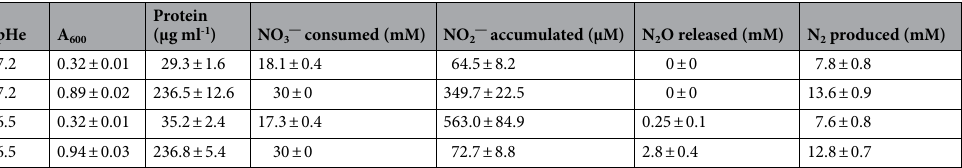
quantitative proteomic analysis by Liquid Chromatography-Mass Spectrometry/Mass Spectrometry (LC–MS/ MS). The principal component analysis (PCA) and the clustering of these biological replicates are shown as sup- plementary material (Figs. S1 & S2). Total proteins identified were 1157 at pH 6.5, 1734 at pH 7.0, 2014 at pH 7.2 and 1878 at pH 7.5 (Fig. 1B). Thus, the highest number of proteins was identified at pH 7.2, with 2014 proteins from ~ 5100 putative structural genes present in the P. denitrificans genome (~ 40% representation of the total predicted gene products). The protein profile obtained at pH 7.2 was used as the reference condition, and differential analyses were performed by comparison of the proteome at pH 7.2 with those at pH 6.5, 7.0 or 7.5. In these comparative pro- teomic analyses, the term ‘exclusive’ describes proteins with an absolute value of fold change higher than 100, whereas proteins shared at both analysed pHs, but nevertheless differentially represented with fold changes lower than 100, were considered ‘over-represented’ (positive fold change) or ‘down-represented’ (negative fold change) at the reference pH 7.2. The most drastic differences were observed when comparing the proteomes at pH 6.5 and 7.2, with a total of 922 proteins affected, of which 702 were exclusive to pH 7.2 and 10 were exclusive to pH 6.5. Another 158 proteins were over-represented at pH 7.2 (down-represented at pH 6.5) and 52 proteins were over-represented at pH 6.5 (down-represented at pH 7.2) (Table S1). A total of 584 proteins were differentially represented when comparing the proteomes at pH 7.0 and pH 7.2. In this case, 262 proteins were exclusive to pH 7.2, 85 were exclusive to pH 7.0 and 237 were shared at both pHs, with 148 proteins over-represented at pH 7.2 and 89 over-represented at pH 7.0 (Table S2). When comparing the proteomes at pH 7.5 and 7.2, 637 proteins were differentially represented, with 209 proteins exclusive to pH 7.2, 127 exclusive to pH 7.5 and 301 shared between both pHs, of which 172 were over-represented at pH 7.2 and 129 were over-represented at pH 7.5 (Table S3). The Gene Ontology (GO) categories 21 from the comparative analysis between pH 6.5 and 7.2 are shown (Fig. 2). Breaking down the proteome into GO groups gives insight into functional protein categories that are either enriched (over-represented) or suppressed (down-represented) under denitrifying and nitrate assimilating conditions. Proteins over-represented at pH 7.2 belonged to significantly changed GO groups ‘transmembrane transport’, ‘metabolic process’ ‘pentose phosphate shunt’, ‘pantothenate biosynthetic process’, ‘cobalamin biosyn- thetic process’, ‘leucine biosynthetic process’, ‘glutamine biosynthetic process’, ‘porphyrin-containing compounds biosynthetic process’, ‘biotin biosynthetic process’, ‘glyoxylate cycle’ and ‘nitrate metabolic process’, among others (Fig. 2A). Down-represented proteins at pH 7.2 belong to the GO groups ‘cell cycle’, ‘cell division’, ‘cell morpho- genesis’, ‘regulation of cell shape’, ‘cell wall organization’ and ‘hydrogen sulphide biosynthetic process’ (Fig. 2B). Effect of pH on peptide representation of proteins involved in denitrification and nitrate assimilation. The catalytic subunit of the assimilatory nitrate reductase NasC was negatively affected at pH 6.5, showing increased amounts of its peptides at pH 7.2 (3.06-fold change). Increased peptide intensities cor- responding to other proteins encoded by the assimilatory nasTSABGHC gene cluster of P. denitrificans 22 were also found at pH 7.2, except for the assimilatory nitrite reductase NasB, which was not significantly affected at pH 6.5 (Fig. 3, Table S1). Several denitrification proteins encoded by the nar , nir , nor and nos gene clusters were negatively affected at pH 6.5 (Fig. 3, Table S1). Thus, identified peptides that belong to the catalytic subunit of the respiratory nitrate reductase NarG were over-represented in the proteome at pH 7.2 (3.36-fold change). Additionally, peptides from the cd 1 -type nitrite reductase NirS and a putative protein involved in its maturation, annotated as cytochrome d 1 -heme region, were over-represented at pH 7.2 (3.33- and 6.61-fold change, respectively). Furthermore, NosZ, the last denitrification enzyme, was also found over-represented at pH 7.2 (2.80-fold change). However, peptides from nitric oxide reductase NorC were identified and quantified by LC–MS/MS, but they were not significantly affected by extracellular pH. Other proteins participating in the denitrification process were either over-repre- sented at pH 7.2, such as the regulatory protein NosR (4.85-fold change), or exclusive to pH 7.2 like the FMN transferase NosX (Fig. 3, Table S1). Determination of enzymic activities involved in nitrate, nitrite and N O reduction. Activities 2 of reductases involved in denitrification or nitrate assimilation were determined in P. denitrificans cells grown under denitrifying conditions at different pHs (Fig. 4). Nitrite reductase NirS activity was similar at all tested